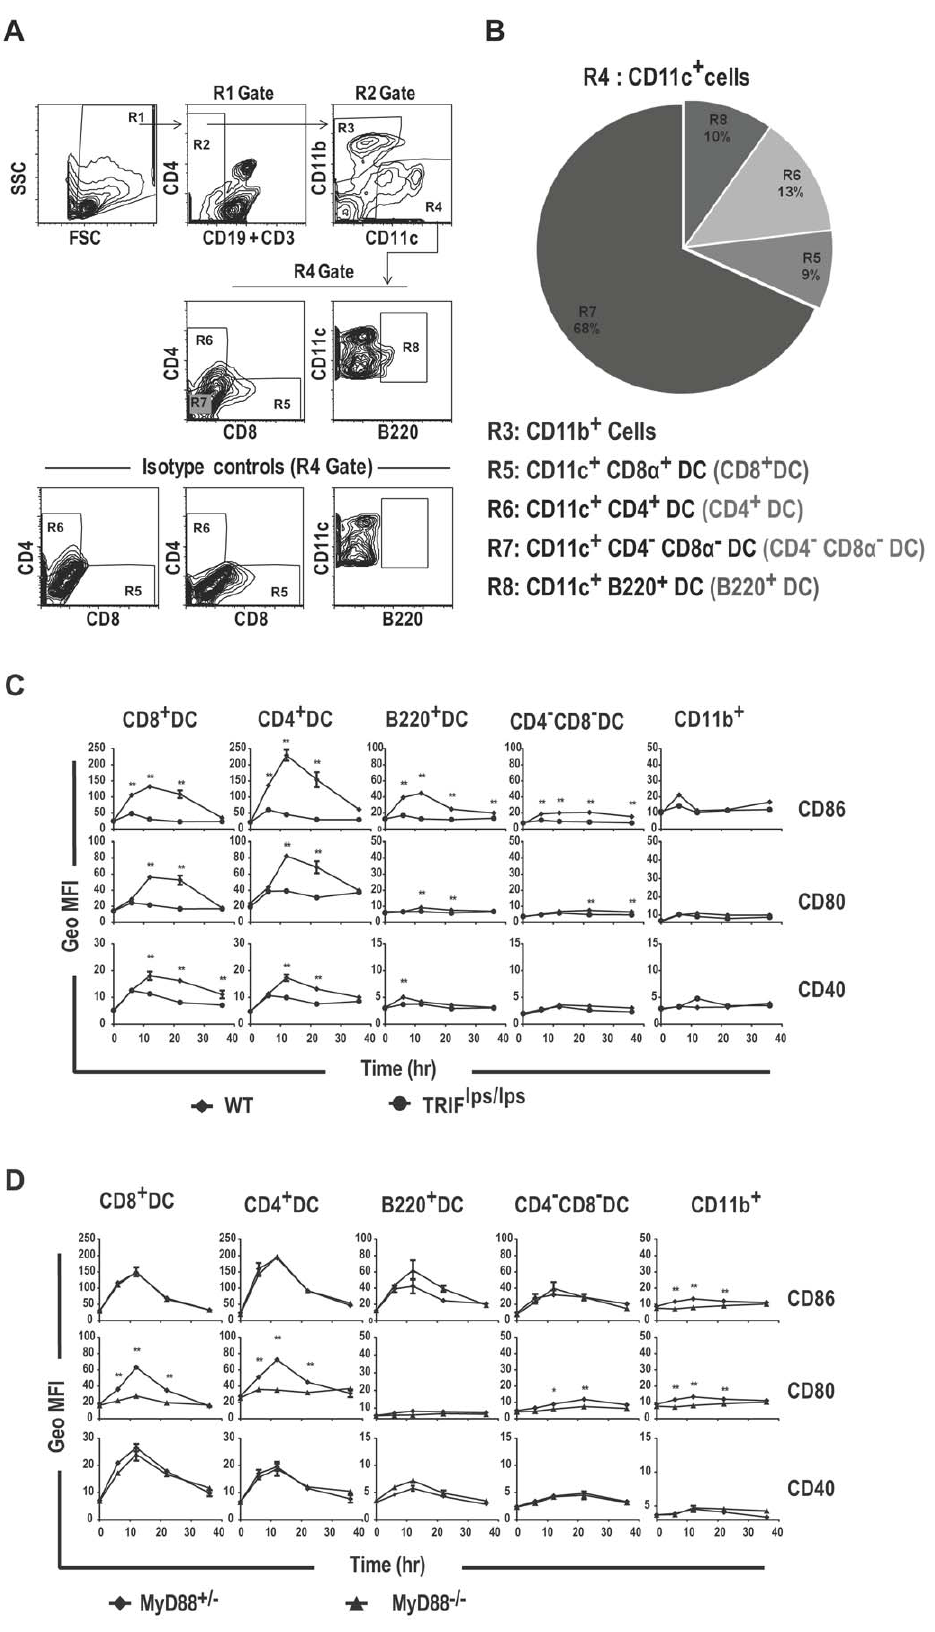
Figure 2. TLR4-mediated upregulation of co-stimulatory molecules on splenic DC subsets in vivo occurs in a TRIF dependent manner. Spleens from WT, TRIF lps/lps , MyD88 2 / + and MyD88 2 / 2 mice that had been injected with Lipid A (10 m g/mouse) or with saline were